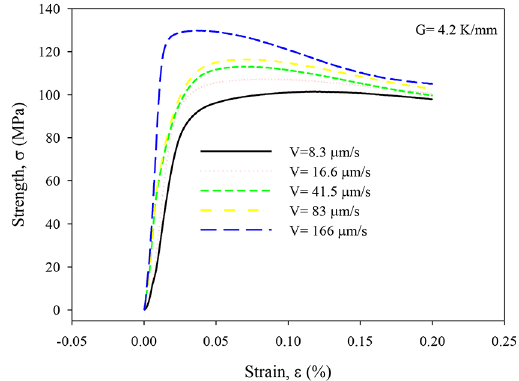
Figure 8. Typical strength-strain curves of Sn-36Bi-22Cu eutectic alloy for different V at a constant G